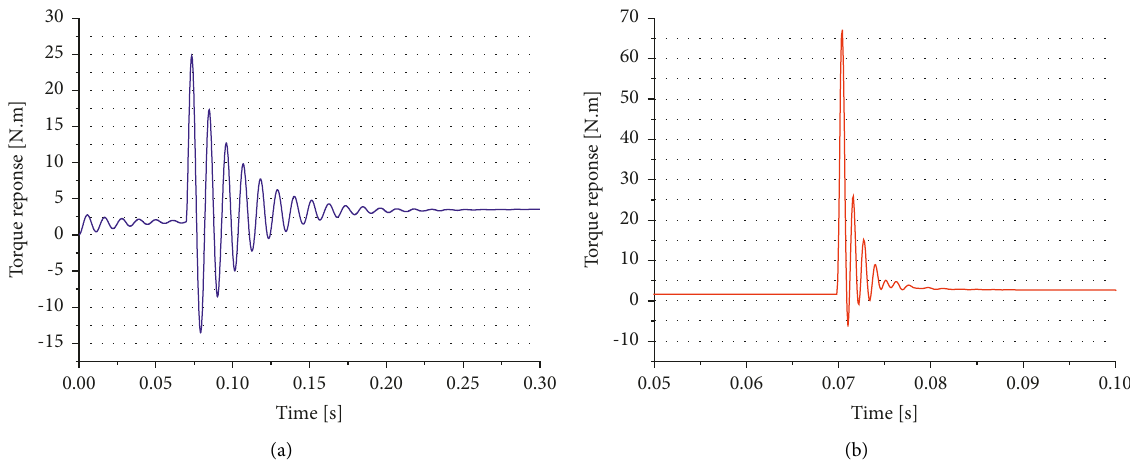
Figure 9: Torque response under impact loading: (a) shaft between the driven unit and the pinion gear and (b) engaging engine